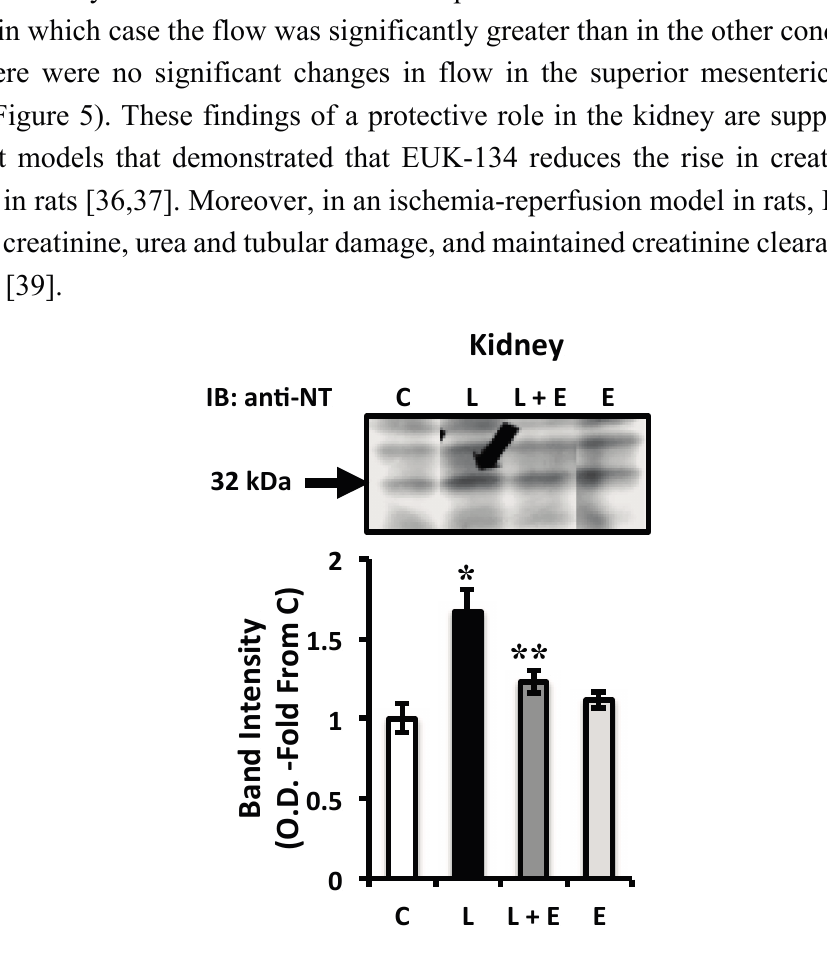
Figure 6. Western blots with anti-nitrotyrosine antibody of homogenates of renal tissue. There was an increase density at a band at 32 kDa (marked by arrow) with LPS and this was not apparent when animals were pretreated with EUK-134. Bar graph represents relative band optical density (OD) quantification. C = Control, L = LPS, L + E = LPS plus EUK-134 and E = EUK-134; NT = Nitrotyrosine. * p < 0.05 vs. C; ** p < 0.05 vs.